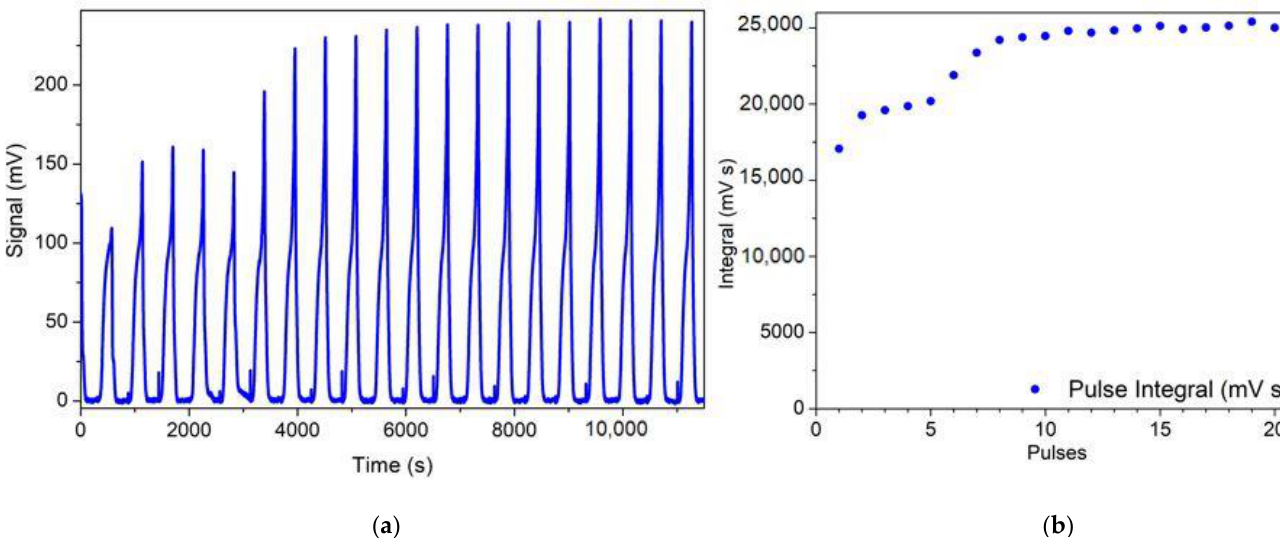
Figure 4. Fresh catalyst sample: ( a ) TCD signal (mV) registered during successive sending of pulse of 800 µL of 10% CO in He carrier until saturation ( b ) Value of integral of the peaks registered.